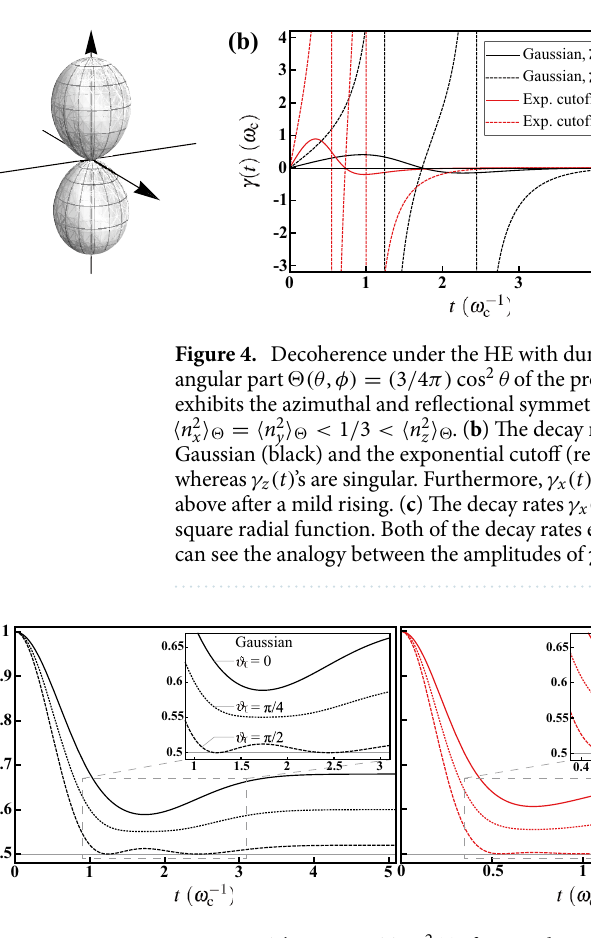
Figure 5. The purities Tr curves), and π/ 2 (dashed curves), respectively. Aforementioned relation between the purity and γ j ( t ) ’s in Fig. 4 can also be observed. However, due to the regime implies larger purity for ϑ 0 therefore lead to a full die-out of